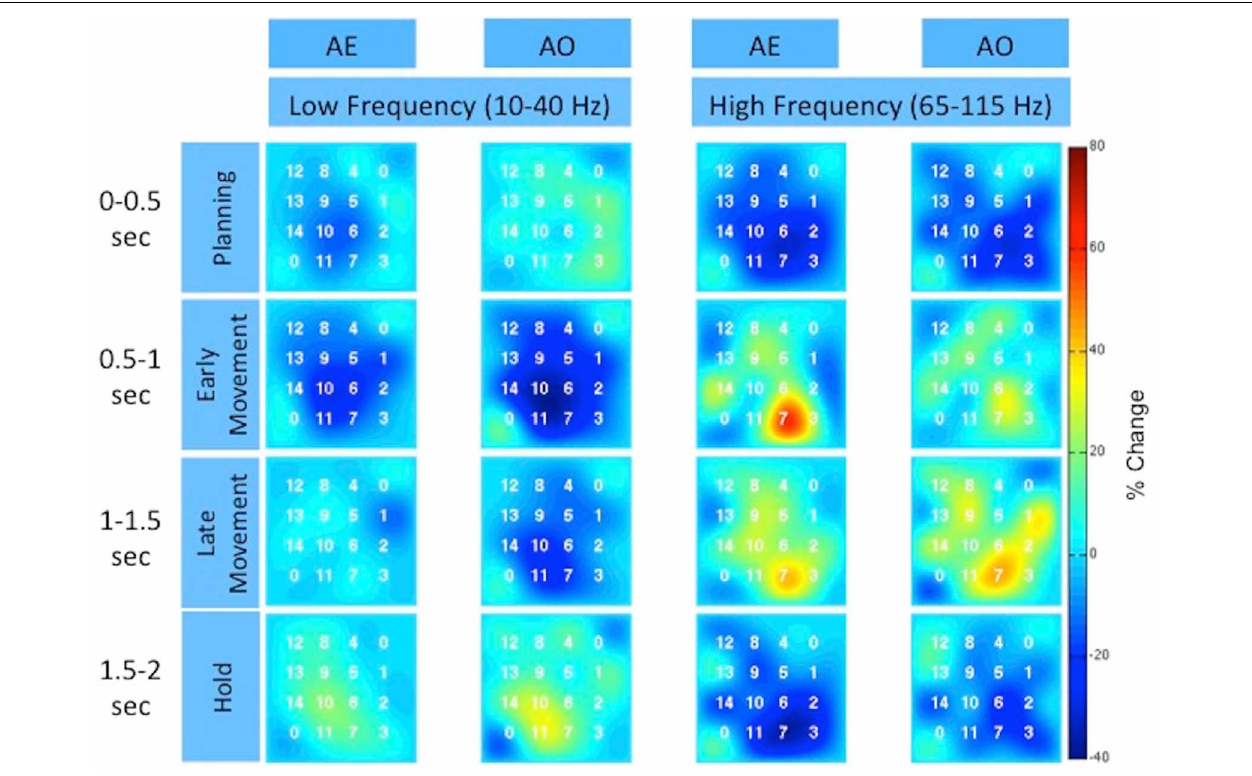
FIGURE 5 | Spatiotemporal distribution of the low and high frequency band across the high-density ECoG grid for Subject F. The time intervals are relative to stimulus onset. The color indicates the percent change in the